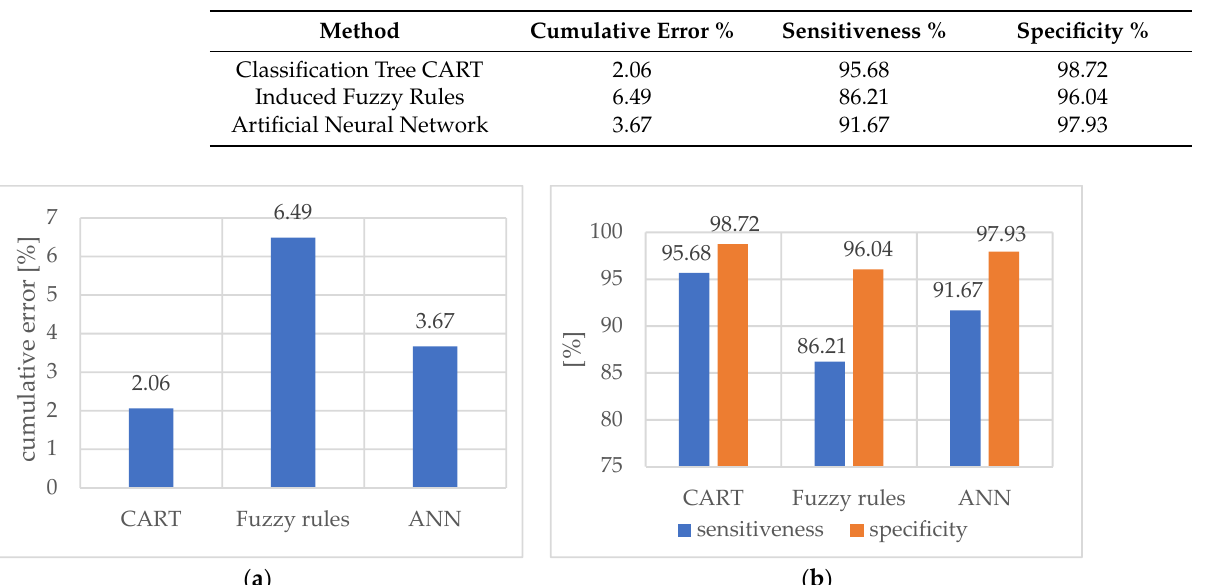
Table 4. Final results of three classification methods (without the cutting parameter v c ).